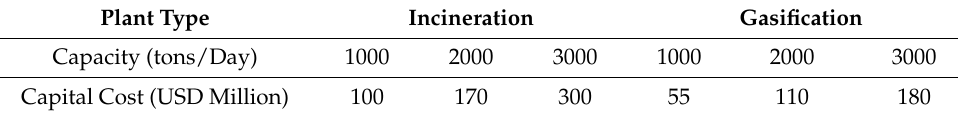
Figure 9. Techno-economic analysis (TEA) approach flow diagram. Table 6. Capital cost and plant capacity per ton for incineration and gasification plants [8].